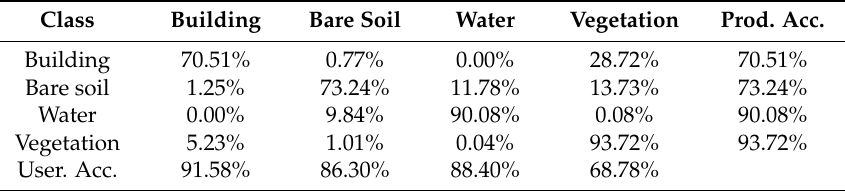
Table 2. Confusion matric of the LE-IF KNN classification result.